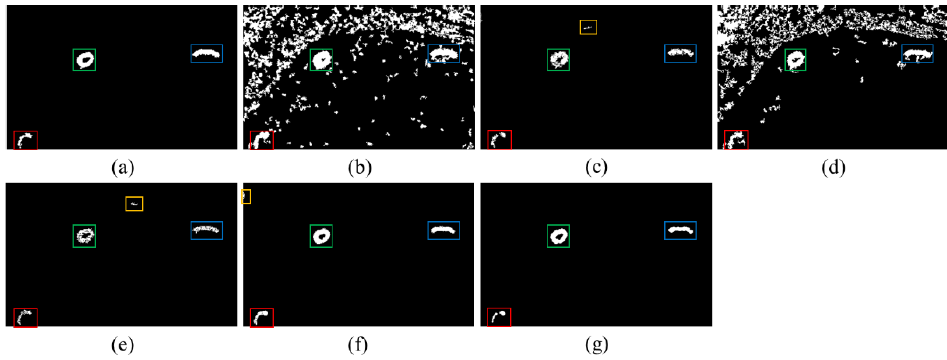
Figure 15. Visualization of comparative experiments for the Yellow River B dataset. ( a ) Ground-truth image. ( b ) Result of PCANet. ( c ) Result of CNN. ( d ) Result of CWNN. ( e ) Result of DDNet. ( f ) Result of SAFNet. ( g ) Result of the presented PCBA-Net. Table 6. Change detection results for Yellow River B dataset.